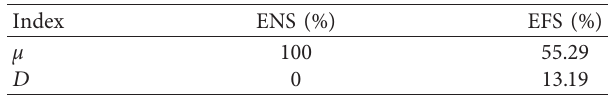
Table 2: The mean and variance of success rate for different indices with SNR � − 5